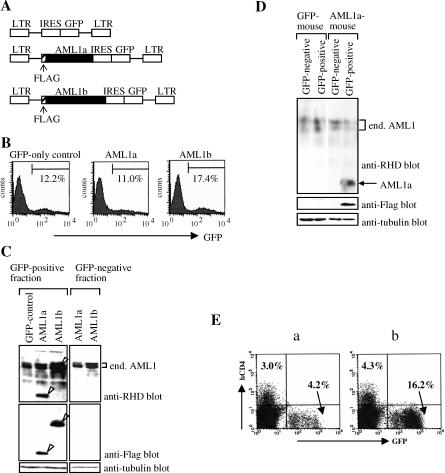
Transduction of Mouse HSCs with AML1 Isoform-Containing Retroviruses(A) Recombinant viruses.(B) FACS analysis of GFP expression in infected hematopoietic cells immediately after infection with control, AML1a-containing, or AML1b-containing viruses.(C) Western blot analysis of lysates from cells sorted immediately after infection by using anti-AML1, anti-Flag, and anti-tubulin antibodies. The anti-AMLl antibody was raised against the Runt domain and therefore detected both human and endogenous mouse AML proteins.(D) Western blot analysis of GFP+ and GFP− BM cells from animals 4 mo after the transplantation (antibodies as in [C]).(E) Typical FACS analyses of BM cells from competitive repopulation assays of AML1a-transduced cells. BM cells of mice transplanted with mixtures of human CD4− and GFP-only-control-transduced cells (a) or human CD4− and AML1a-transduced cells (b) were analysed for expression of human CD4 and GFP.